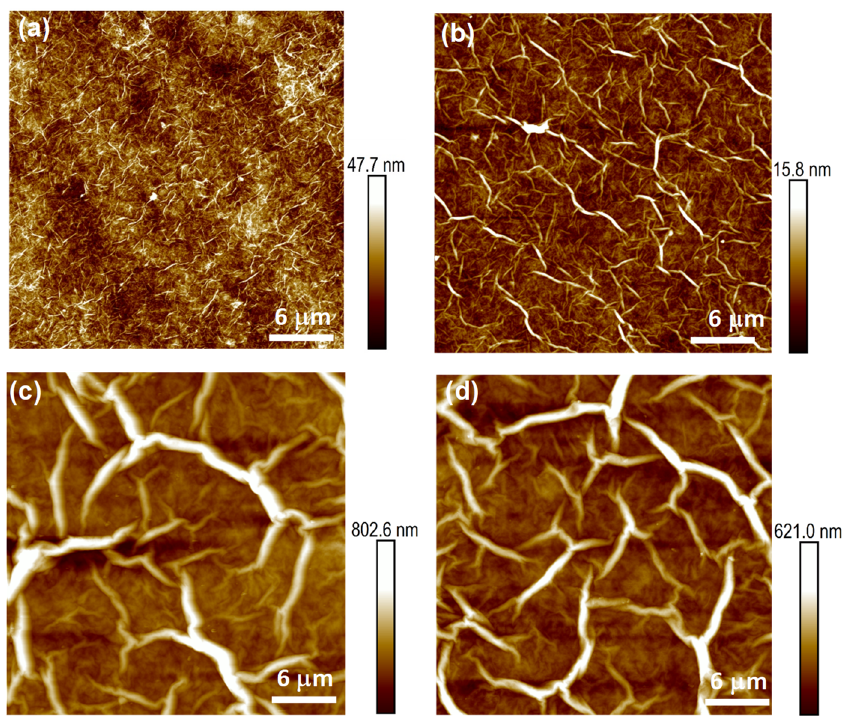
Figure 3. AFM measurements on the surface of the GO sensing films, which were developed by using amounts of 150 μL from GO dispersions with different concentrations: ( a ) 0.33 mg/mL; ( b ) 0.67 mg/mL; ( c ) 1.33 mg/mL; ( d ) 2 mg/mL. ( b ) 0.67 mg/mL; ( c ) 1.33 mg/mL; ( d ) 2